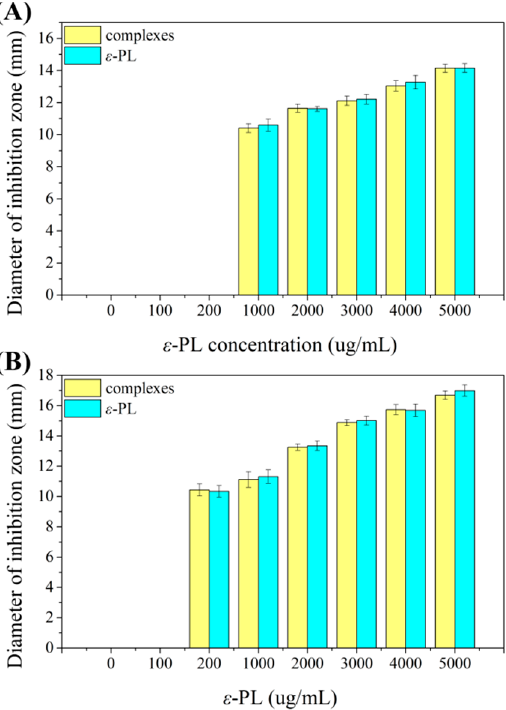
Figure 2. The inhibition zone diameters of ε -PL and whey protein- ε -PL complexes at different concentrations against ( A ) Staphylococcus aureus and ( B ) Bacillus subtilis .